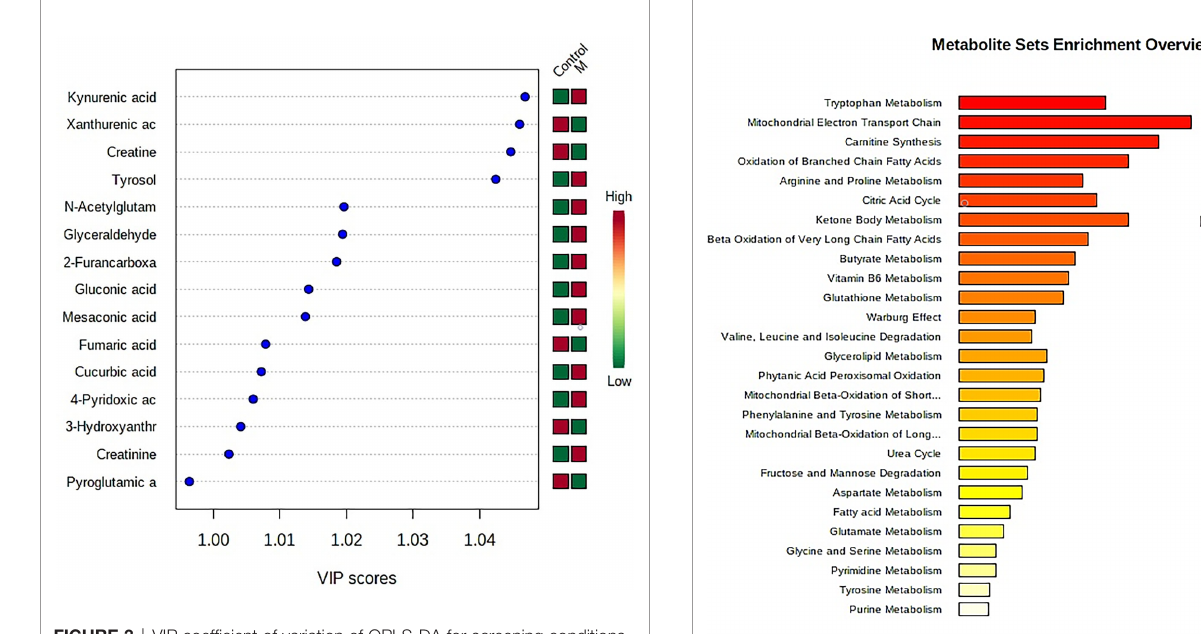
FIGURE 3 | VIP coef fi cient of variation of OPLS-DA for screening conditions for the potential biomarkers. “ Low/high ” refer to high expression and low expression. M, model group.